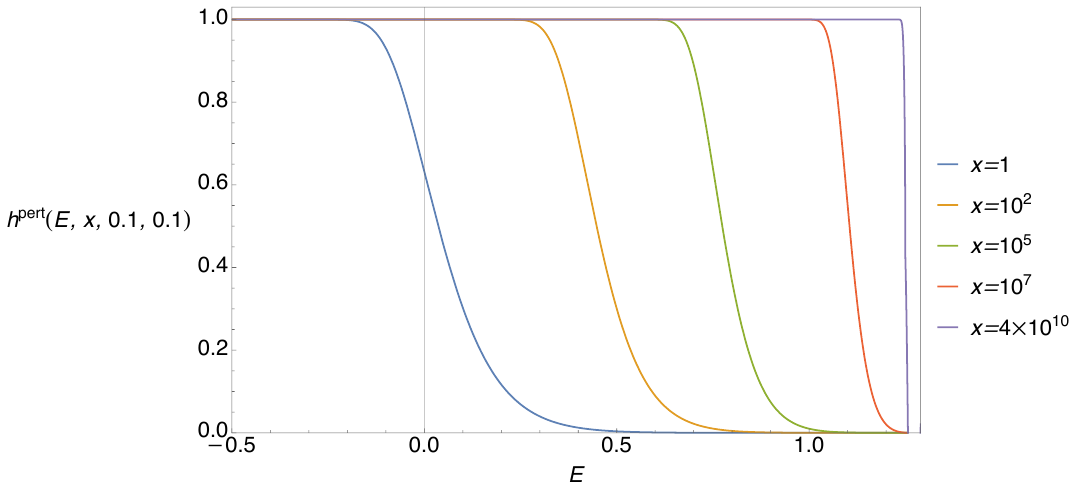
Figure 14. We show the graphs of h pert against E monotonically shifts to the right when x is sufficiently large. We set λ = T = 0 . 1